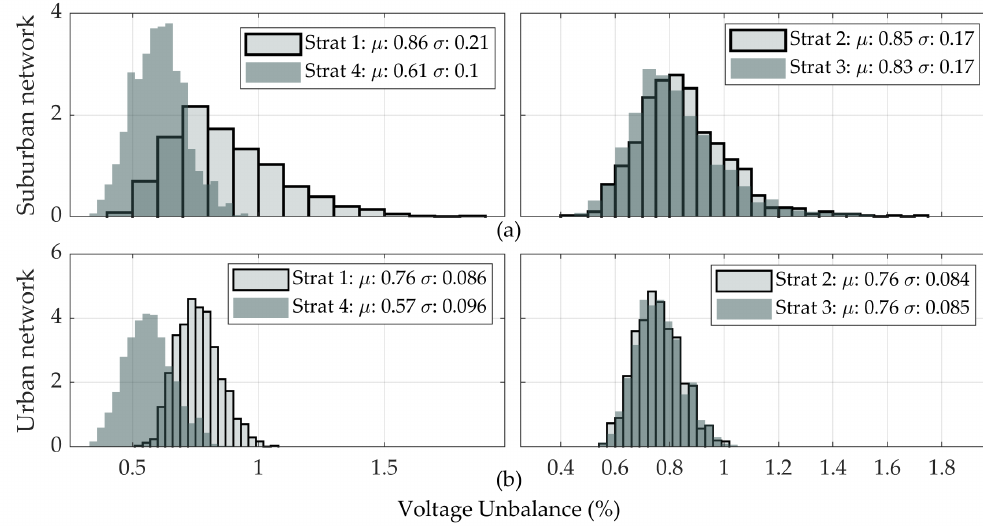
Figure 6. Voltage unbalance in suburban ( a ) and urban ( b ) networks.